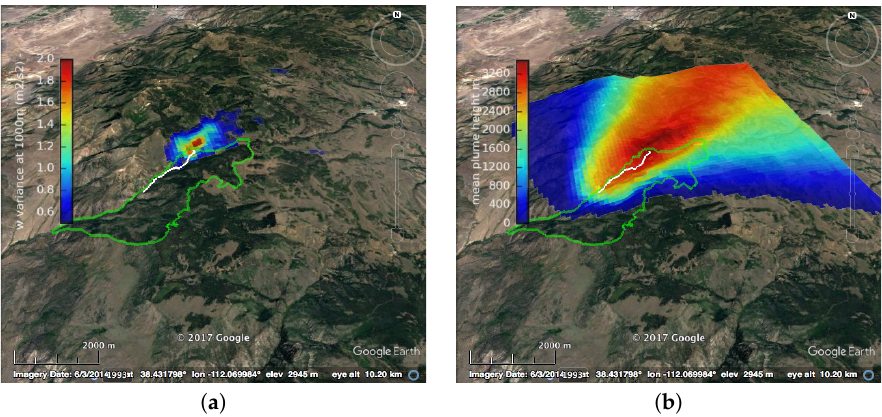
Figure 18. ( a ) The vertical velocity average variance at 1000 m computed from 5 most typical days; ( b ) The mean plume top height computed from 5 most typical days. Green contour represents burn unit boundaries, white line shows the